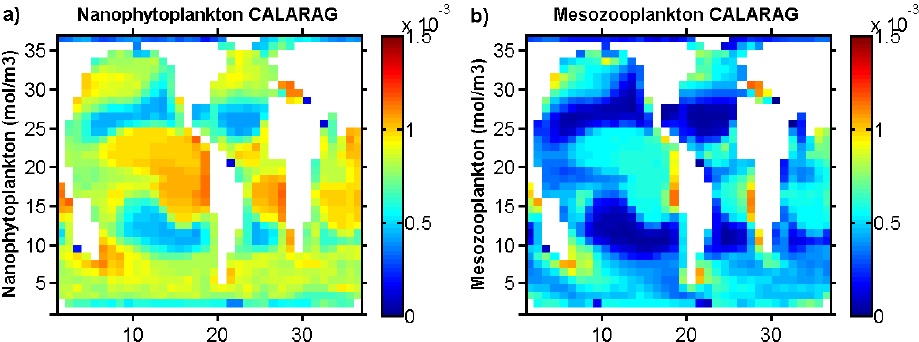
Fig. 4. Spatial distribution of (a) nanophytoplankton and (b) mesozooplankton concentration of the CALARAG model